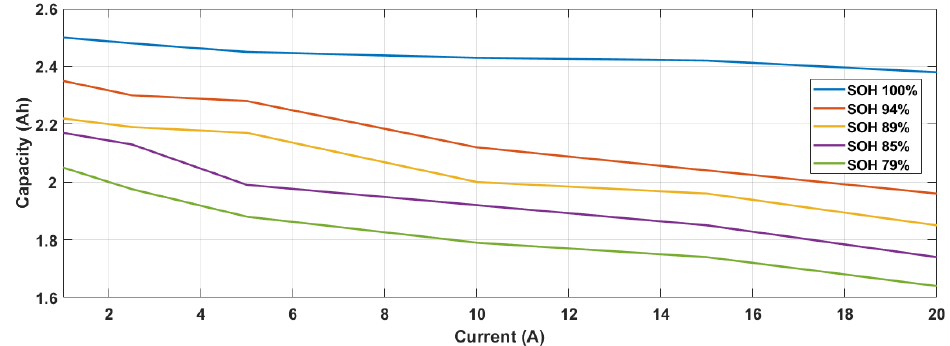
Figure 13. Influence of discharge current and SoH on maximal capacity.